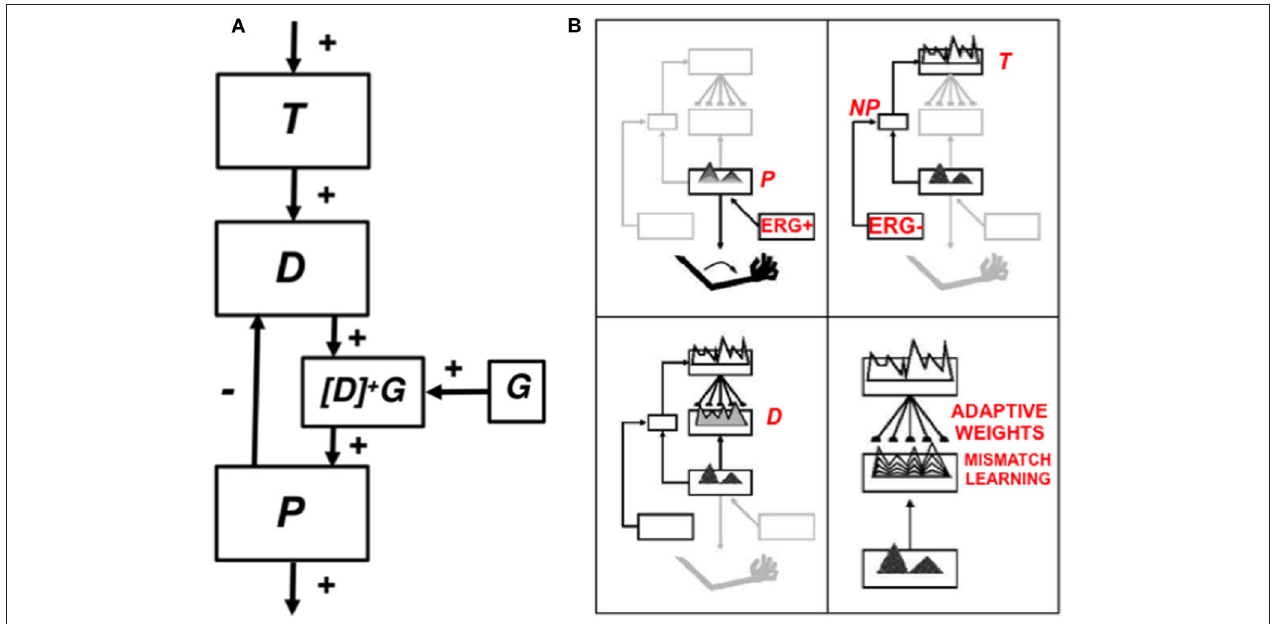
FIGURE 12 | The Vector Integration to Endpoint, or VITE, model of Bullock and Grossberg (1988) realize the Three S’s of arm movement control: Synergy, Synchrony, and Speed. See the text for details [adapted with permission from Bullock and Grossberg (1988)].